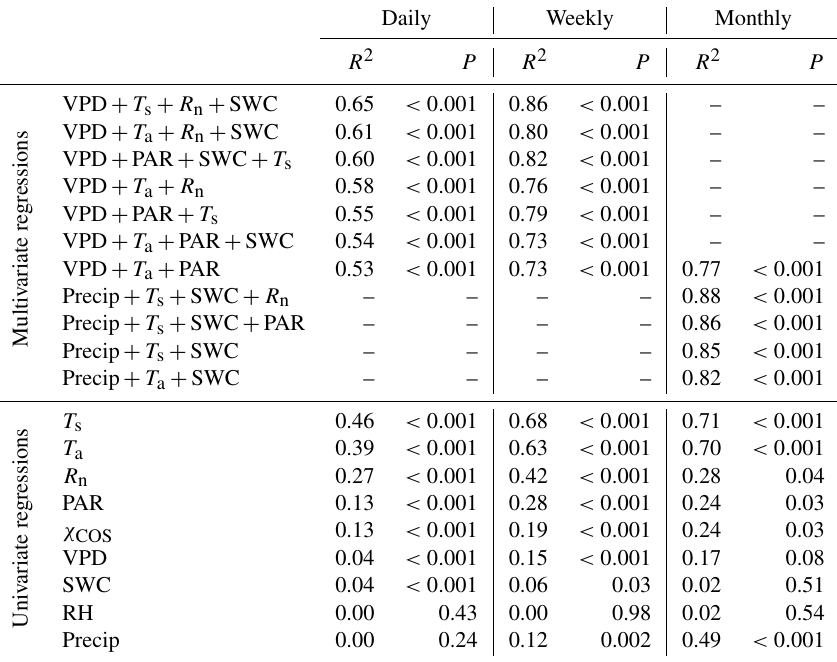
Table 1. Results of the multivariate and univariate regression analysis for carbonyl sulfide (COS) flux at daily, weekly, and monthly timescales. The variables tested are the vapor pressure deficit (VPD), air temperature ( T a ), photosynthetically active radiation (PAR), net radiation ( R n ), soil water content (SWC), soil temperature ( T s ), precipitation (Precip), relative humidity (RH), and the atmospheric COS mixing ratio ( χ COS ). Two variables related to a similar physical quantity were never used in the same model ( T a and T s , PAR and R n , or RH and VPD). All of the models that included more than one variable were tested with the variation inflation factor, which was less than 5 in all cases, showing that the intercorrelation of the variables is